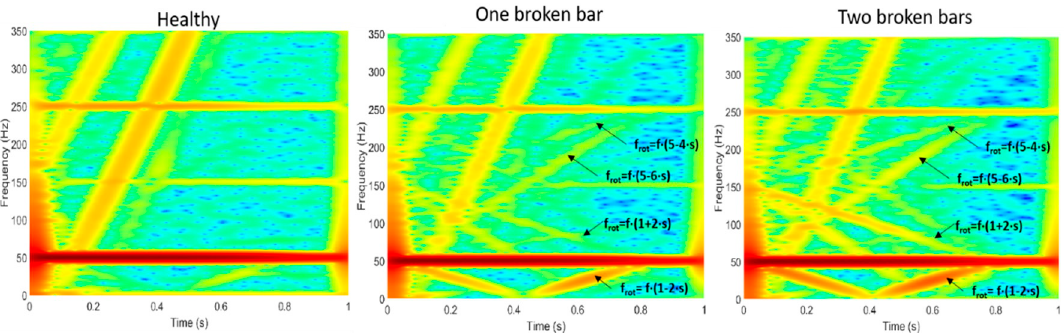
Figure 5. Time-frequency maps of the starting current for different rotor fault conditions.